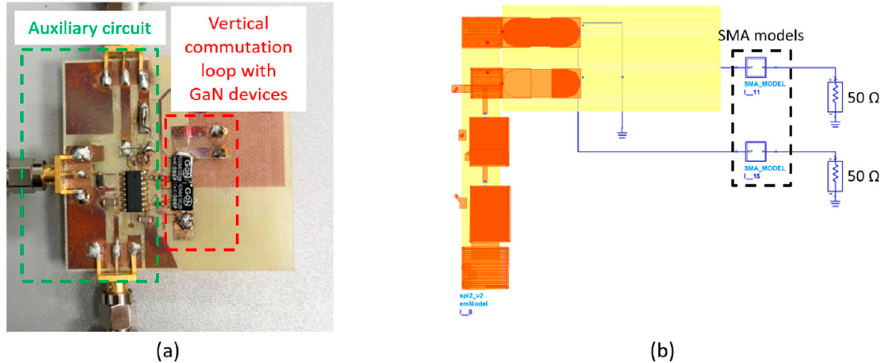
Figure 21. Vertical commutation loop: ( a ) test fixture; ( b ) simulation